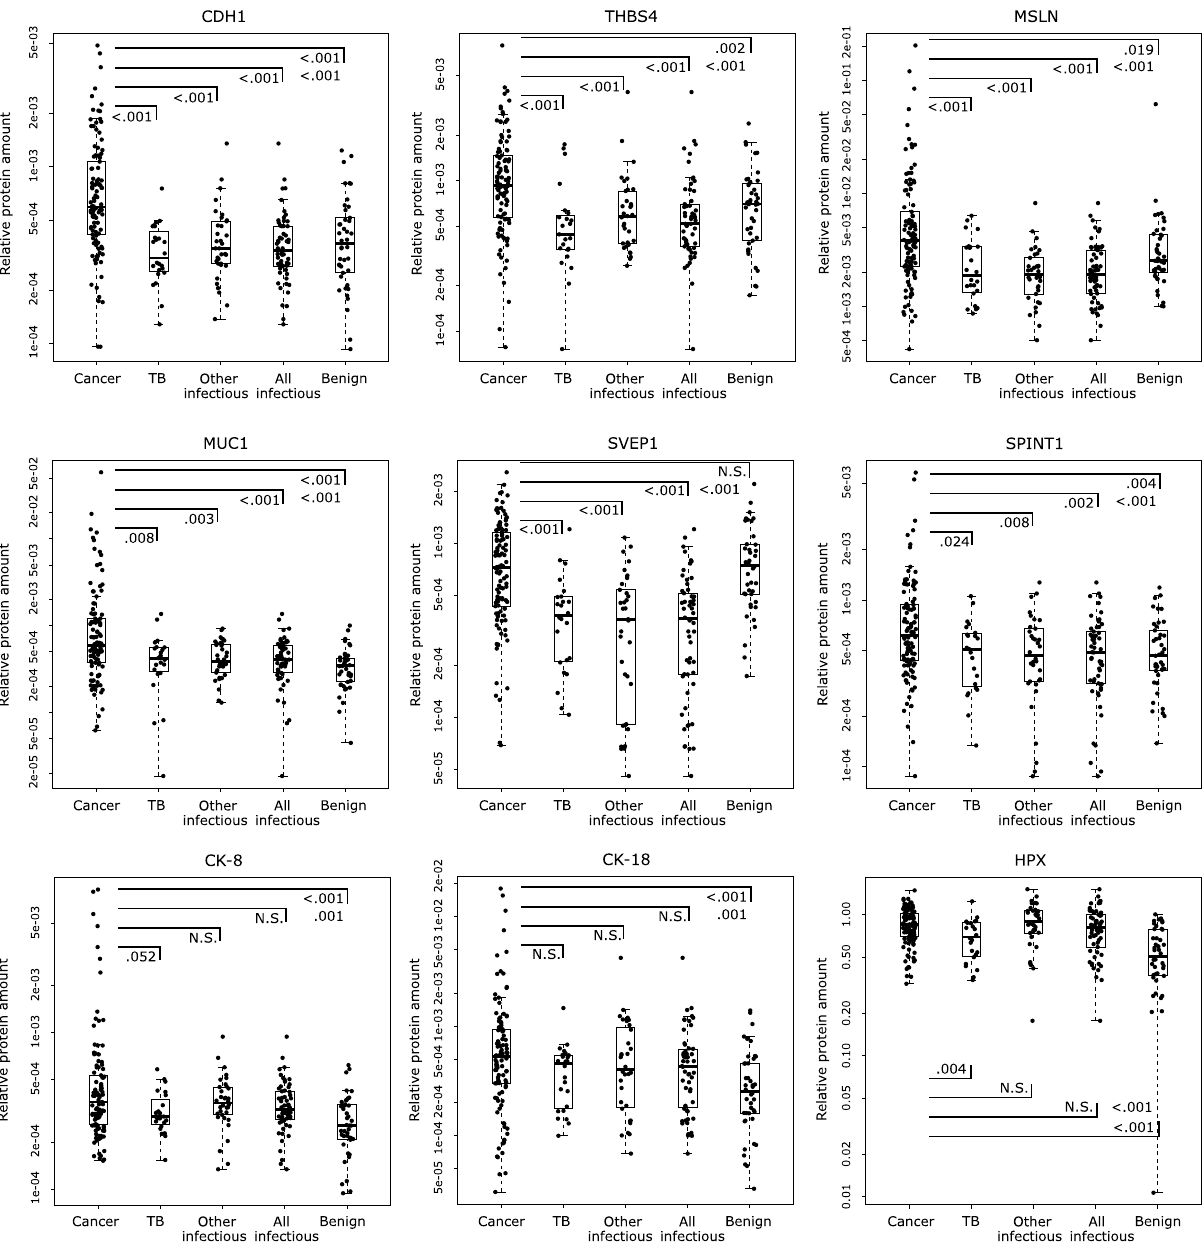
discriminate the cancerous-PE group from the all-infectious-PE group, as well as from the separated TB-PE and other-infectious-PE groups individually, and from all the non-cancerous PEs combined (n = 100), with an AUC ranging from 0.650 to 0.822. For this last comparison, CDH1, MUC1, THBS4, and MSLN were the most effective markers, with AUCs from 0.766 to 0.698. Overall, CDH1 was the best marker for effectively discriminating the cancerous-PEs in all five group comparisons (AUC: 0.734–0.822). In addition to CDH1, the proteins SVEP1, THBS4, and MSLN also effectively differentiated the cancerous-PEs from all three groups of infectious PEs (vs. TB, other-infectious, and all-infectious; AUCs: 0.705–0.777), but they were either not significant (SVEP1) or not as highly significant versus the benign-PEs. MUC1, as well as CK-8 and CK-18, which are clinically utilized cancer markers, were also significantly higher in the cancerous-PEs, although their discrimination ability was generally lower. However, comparing the cancerous-PEs to just the benign-PEs resulted in a higher AUC of